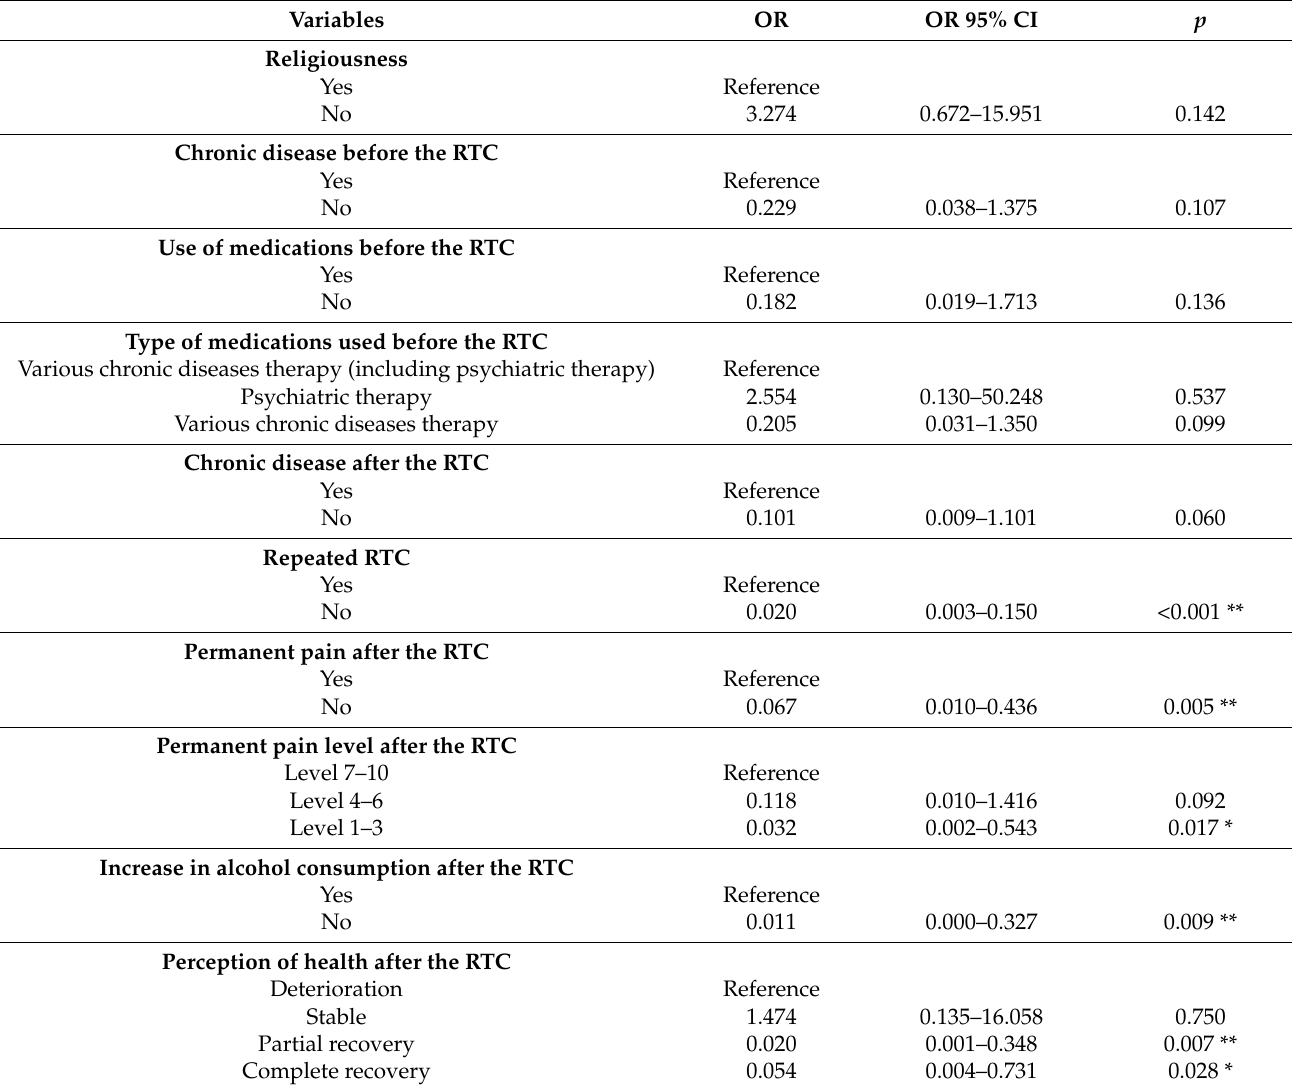
Table 9. The multivariable regression model for depression symptoms at 6-month follow-up.